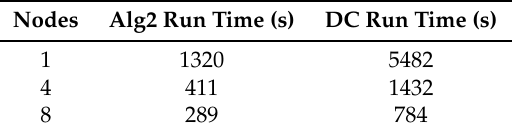
Table 4. Run time comparison with distributed computing method [15] under big input file